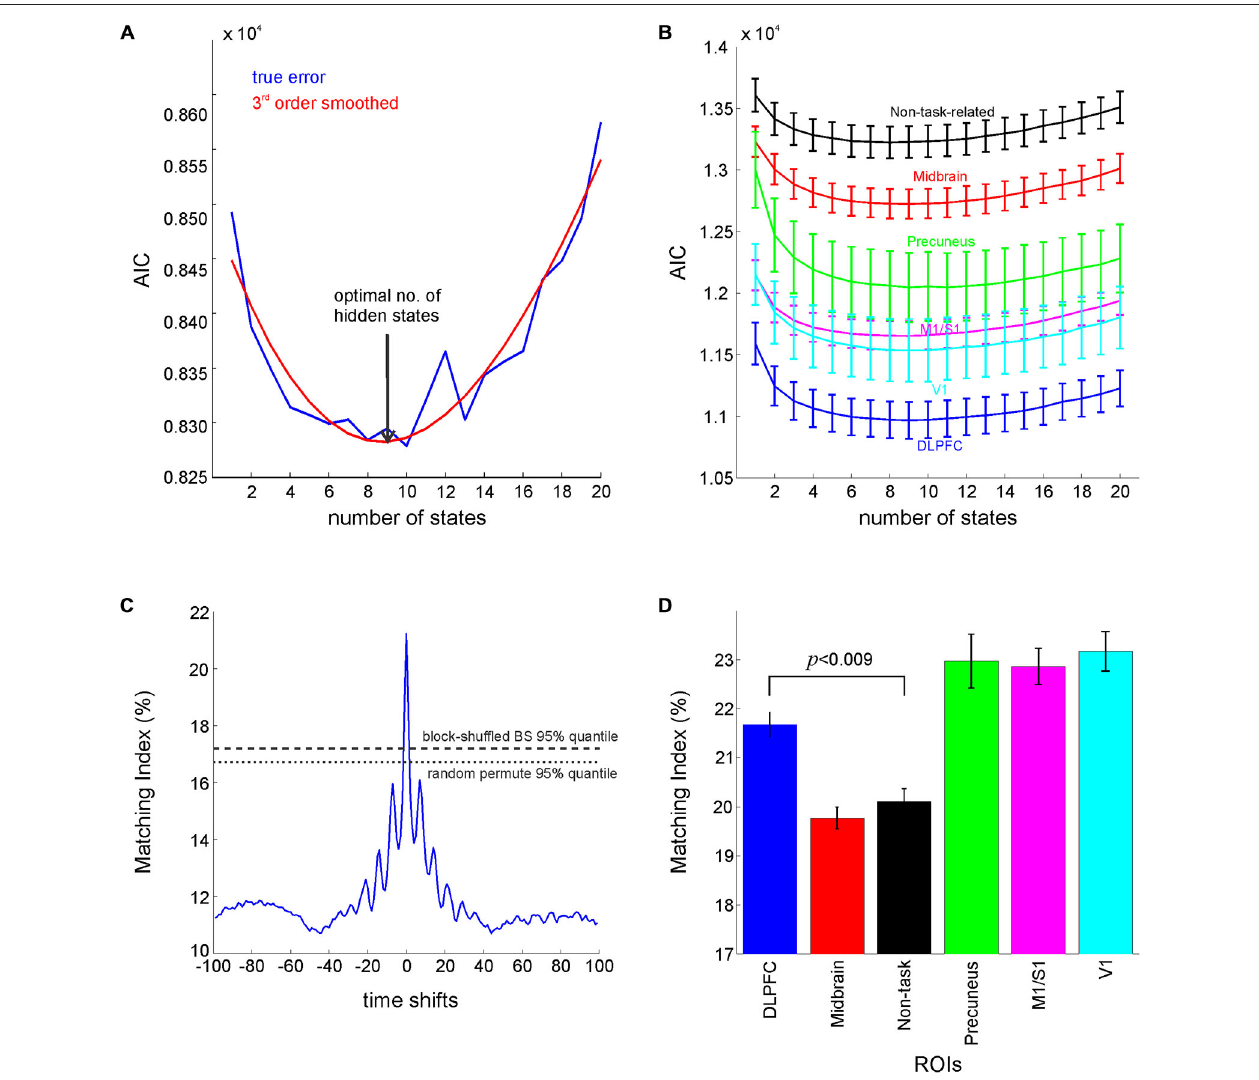
FIGURE 5 | Hidden Markov Models Analysis. (A) AIC (raw: blue, smoothed: red) for the DLPFC attains a minimum around nine states. (B) The goodness of fit (as ssessed by AIC) for different ROIs. (C) Time-shifting bootstraps for testing the significance of the Matching Index between the Viterbi sequence and sequence of behavioral labels, showing significantly higher matching index at zero lag when compared to block or random permutation bootstraps ( α = 0.05). (D) Matching index for different ROIs ( p -value Bonferroni corrected for multiple comparisons) computed as percentage of times points where the behavioral sequence matched the Viterbi sequence. Error bars = SEM across participants. Midbrain label refers to the average of results for midbrain masks (dorsal and ventral striatum, and VTA), and non-task-related label refers to the average of results for Heschl gyrus and